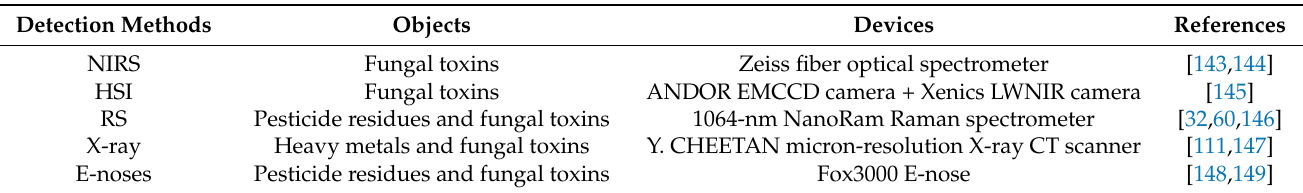
Table 4. Non-destructive inspection methods for safety attributes of cereal